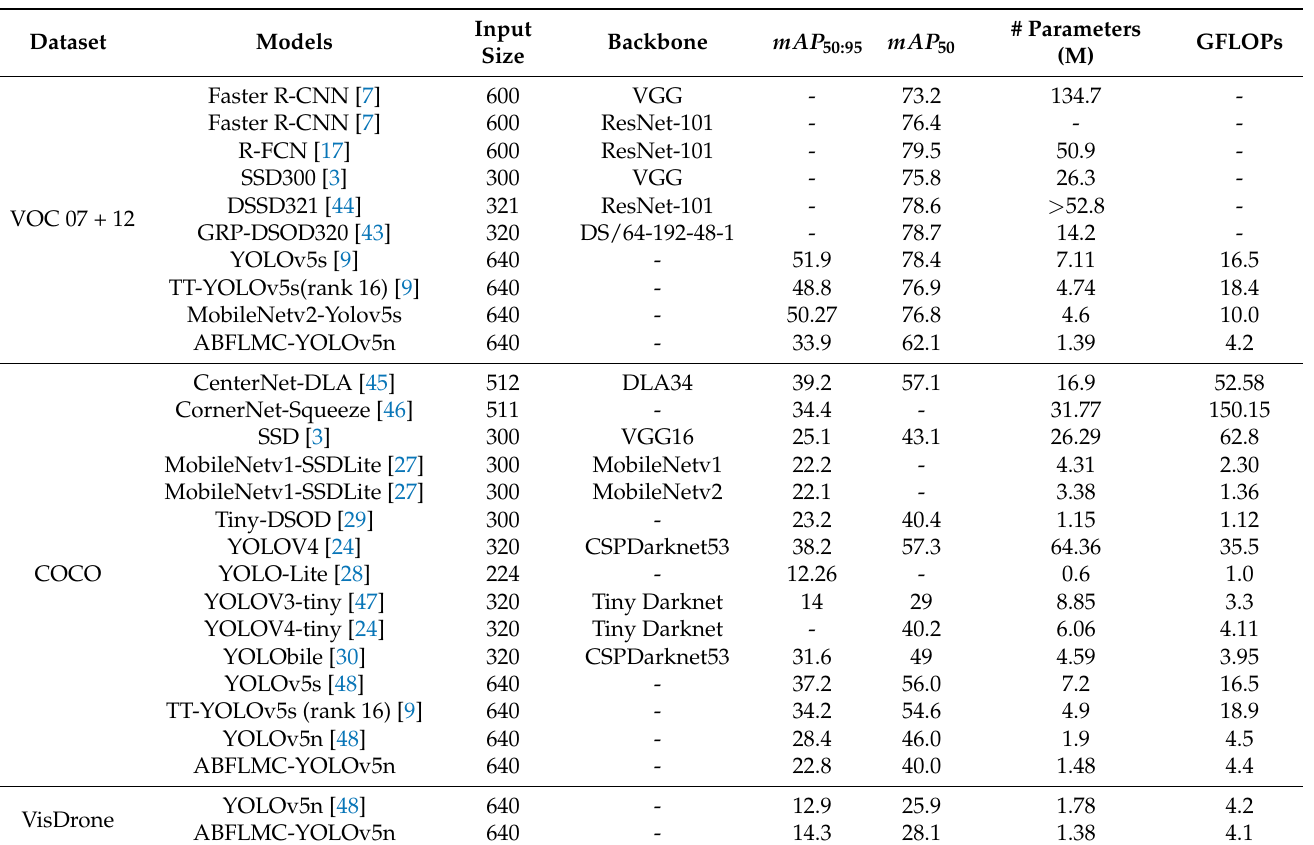
Table 2. Performance Comparison Across Models and Datasets